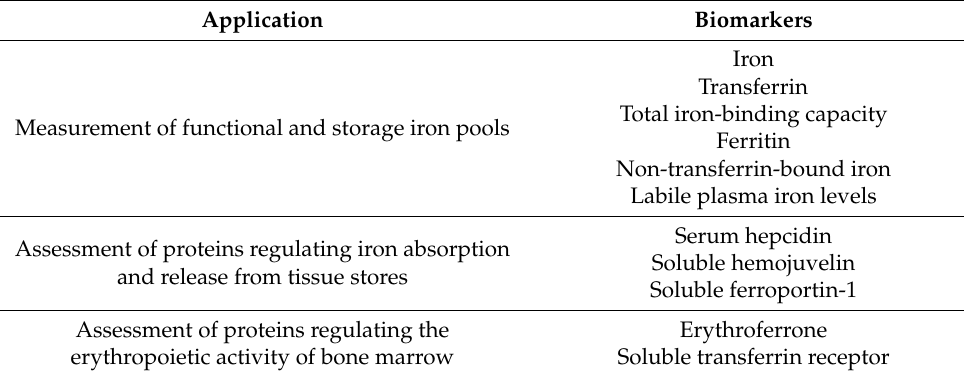
Table 3. Biomarkers of iron